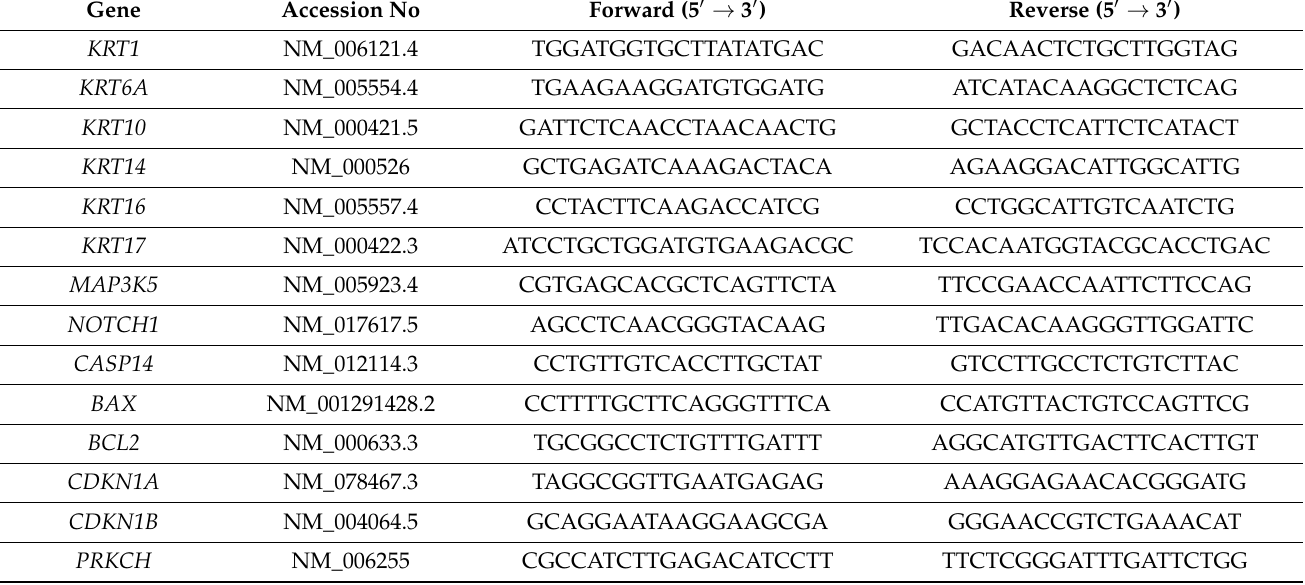
Table 1. Sequences of primers used in real-time